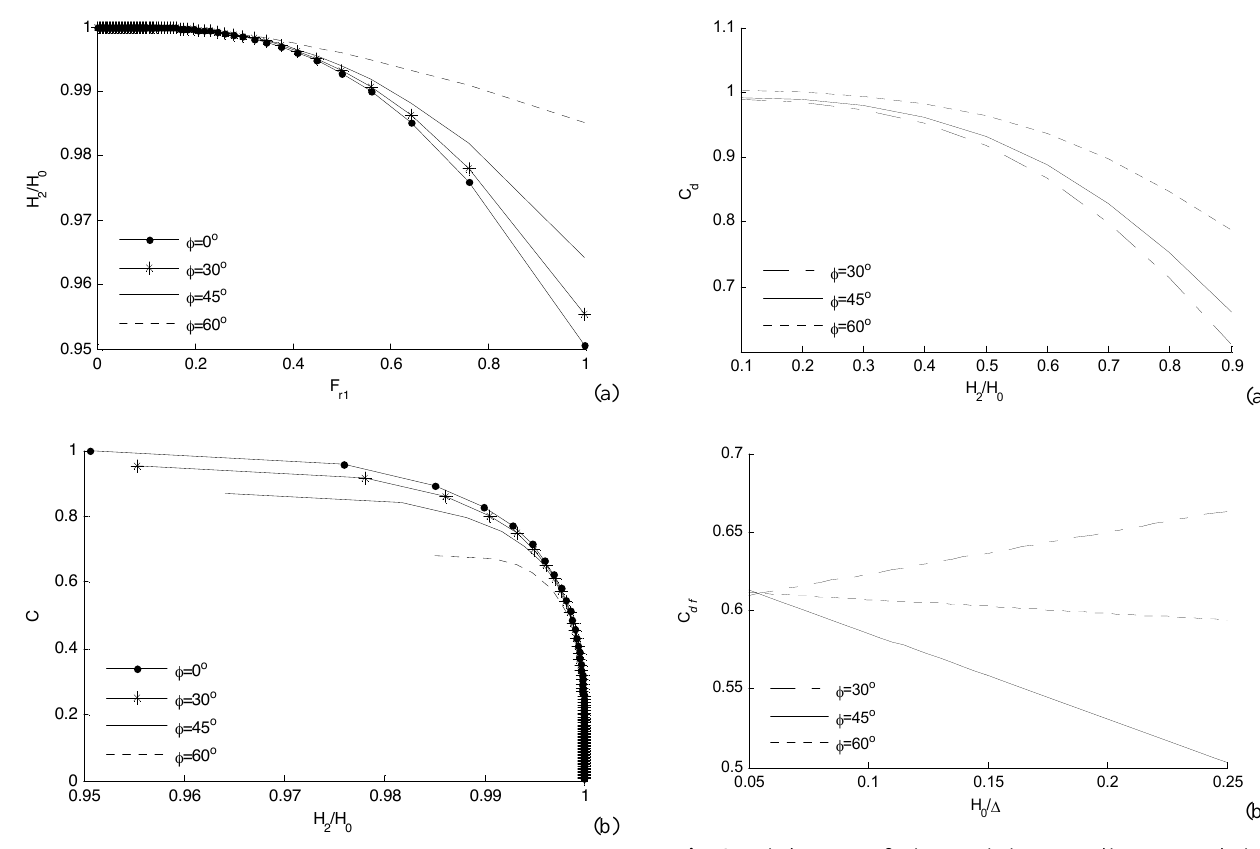
Fig. 7. Variation of energy head loss against the Froude no. on the weir-crest (a) , Variation of discharge coefficient against the energy head loss (b) , for 1 ∗ =0.5.